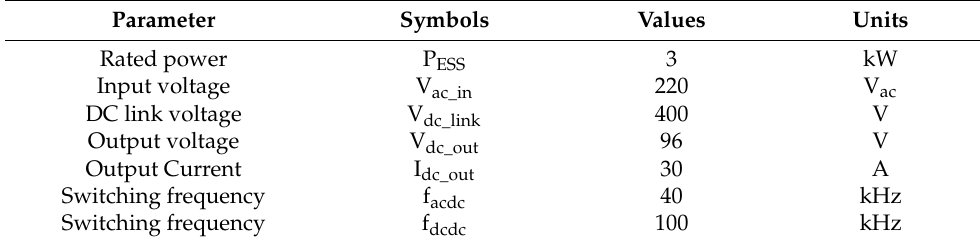
Figure 10. ESS hardware configuration for the application of the proposed algorithm. Table 1. ESS experimental parameters for the application of the proposed